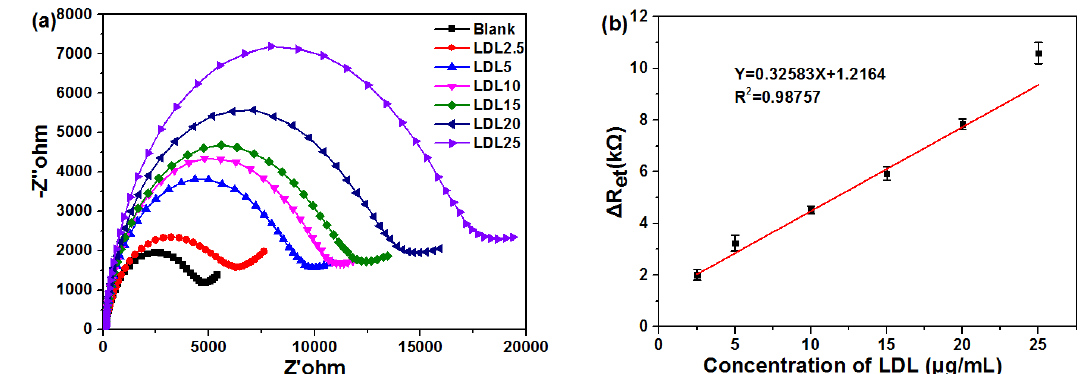
Figure 5. ( a ) Faradaic impedance spectra that corresponded to the fabricated sensor at 25 °C, before and after incubating with different concentrations of LDL in PBS (50 mM, pH 7.0) solution containing 0.1 M KCl and 5 mM K 3 [Fe(CN) 6 ]/K 4 [Fe(CN) 6 ]; ( b ) Calibration curve for the relationship of ΔRet with the LDL concentration.